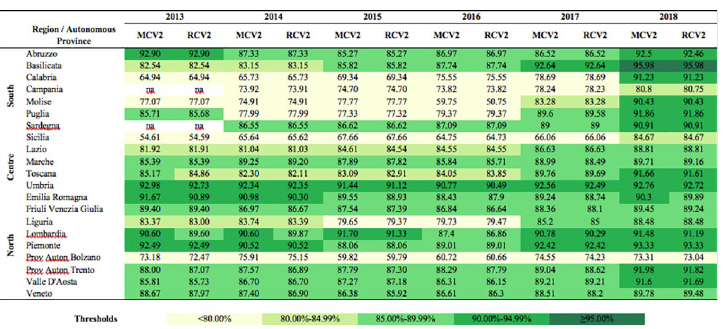
Fig 2. Vaccination coverage for measles and rubella-containing vaccine second dose by Region, Italy, 2013–2018. MCV2 , measles-containing vaccine second dose; RCV2 , rubella-containing vaccine second dose.